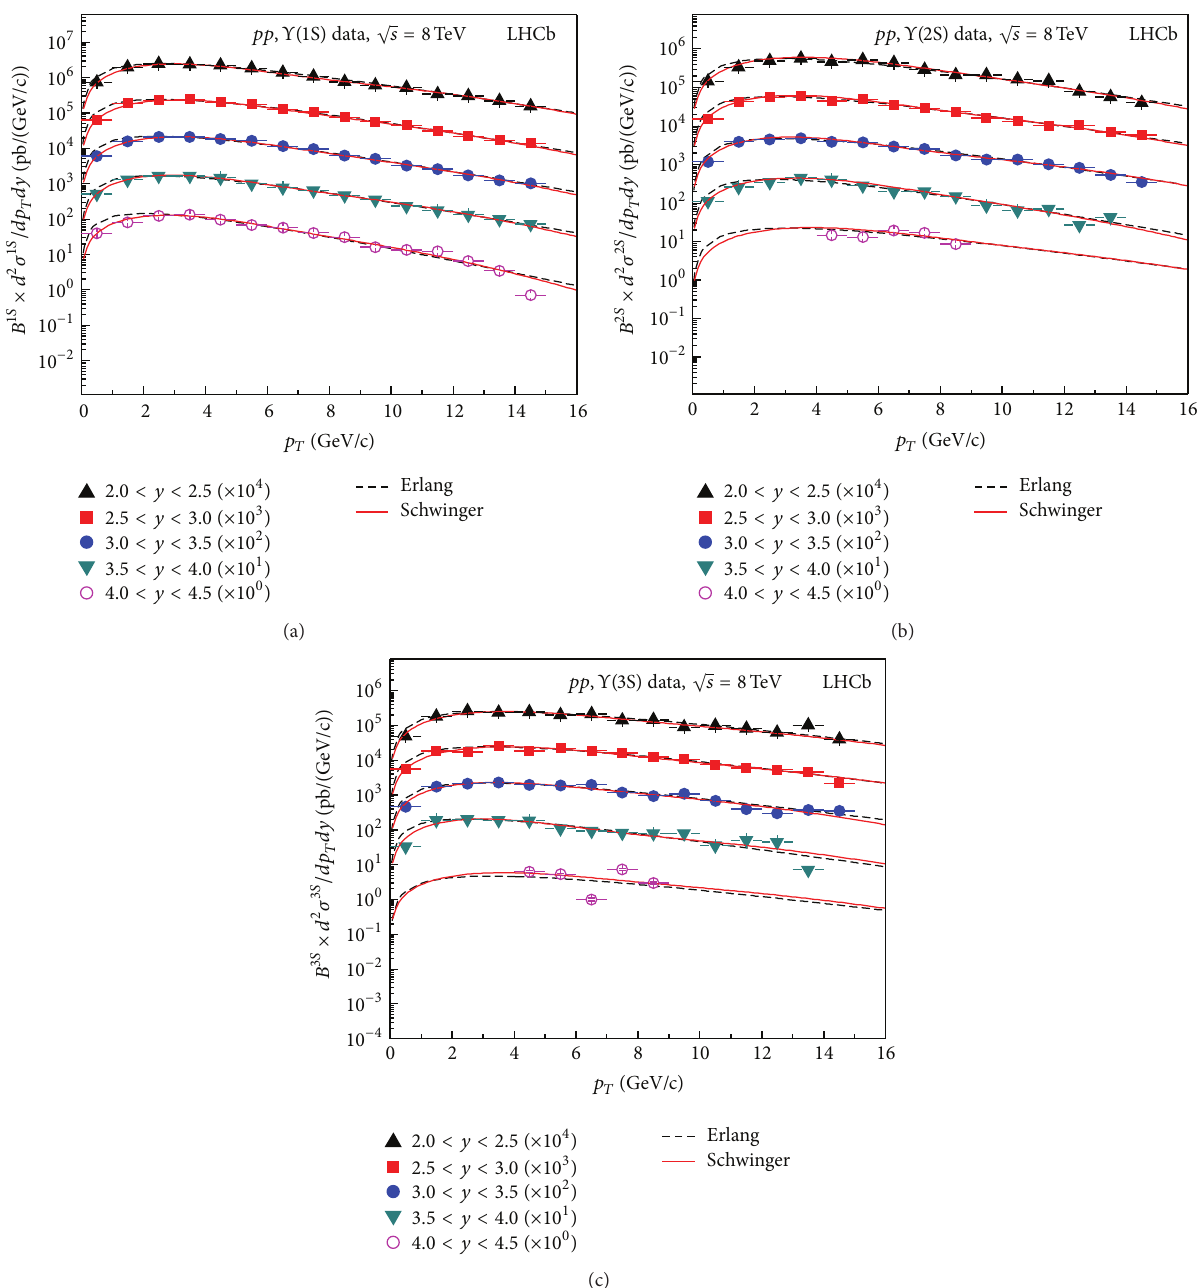
Figure 3: Transverse momentum spectra of (a) Υ(1𝑆) , (b) Υ(2𝑆) , and (c) Υ(3𝑆) mesons produced in 𝑝𝑝 collision at √𝑠 = 8 TeV. The symbols represent the experimental data of the LHCb Collaboration [18]. The dashed and solid curves are our results calculated by using the two- component Erlang distribution and the two-component Schwinger mechanism,